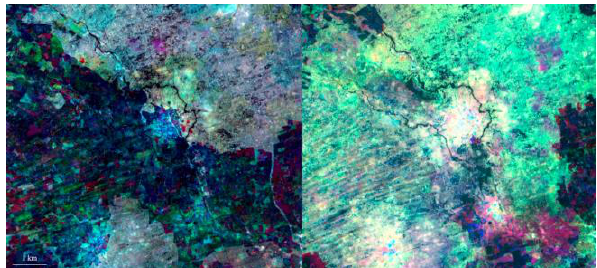
Figure 2 . Severe cropland loss between 2017 (left) and 2019 (right) as detected on 3PTS products (village of